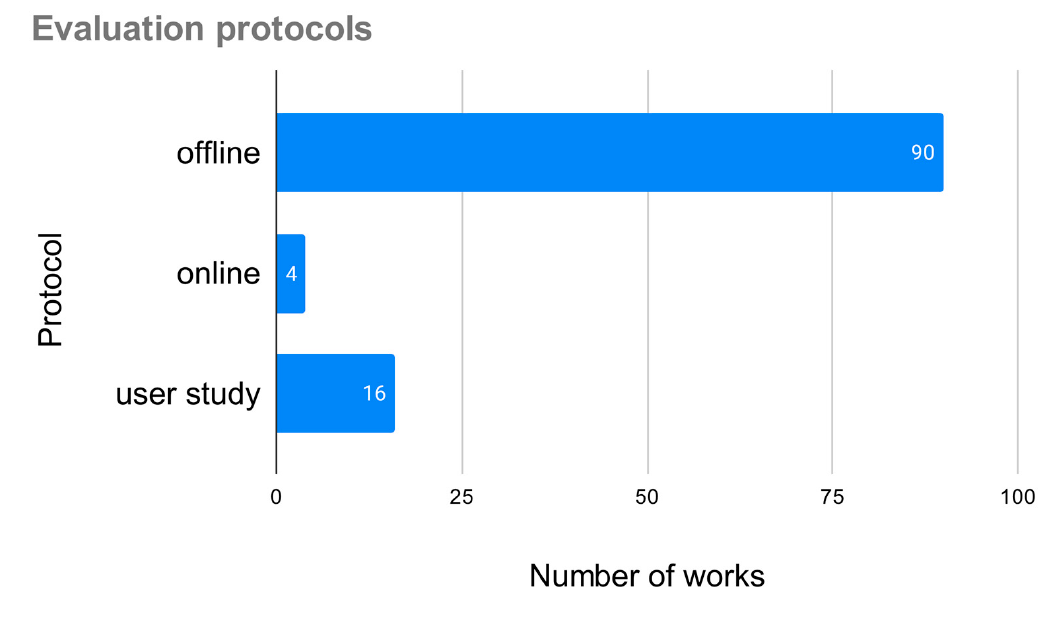
( a ) Figure 6. Cont